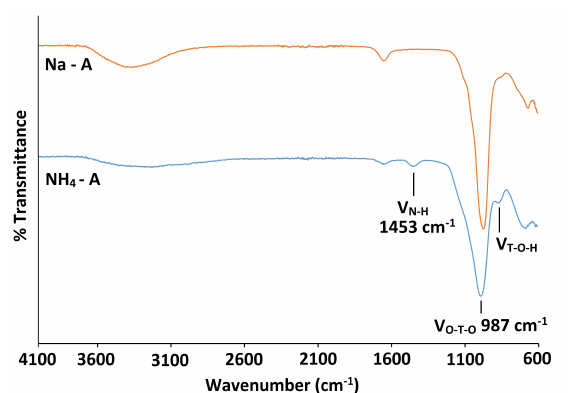
Figure 7. PXRD pattern for NH 4 -A.